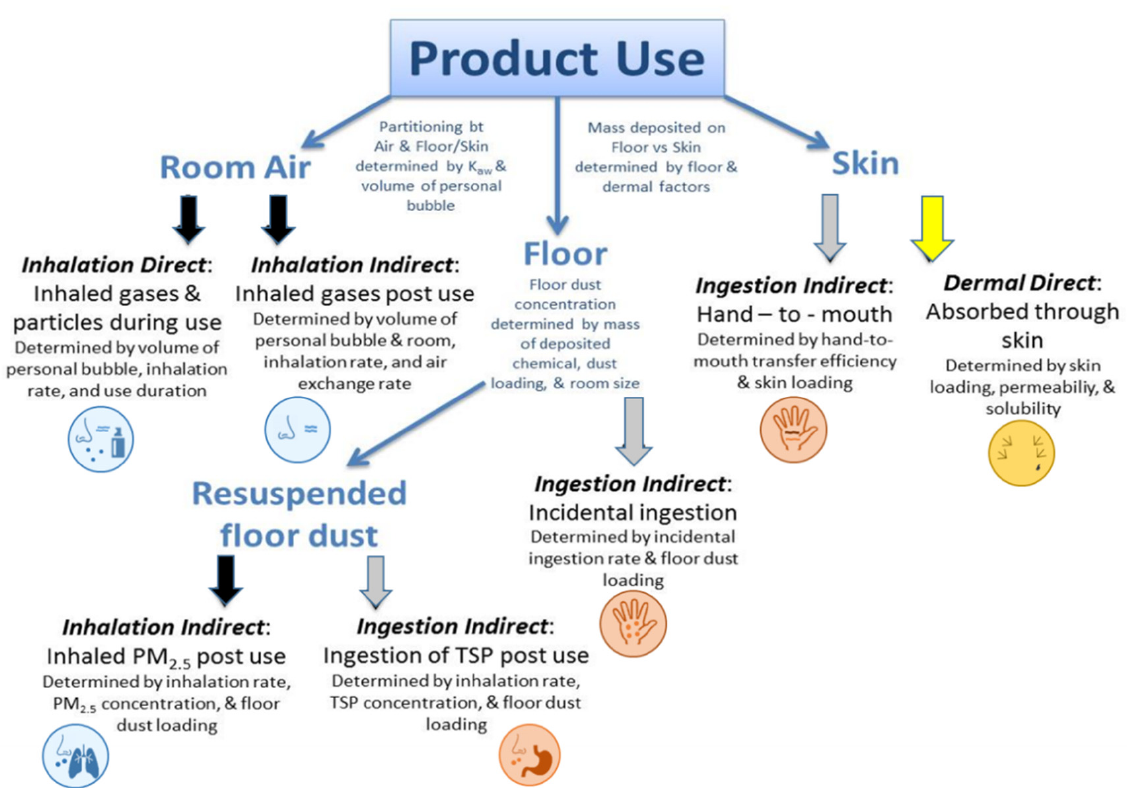
Figure 1. Apportionment of mass by exposure route in Ex Priori .